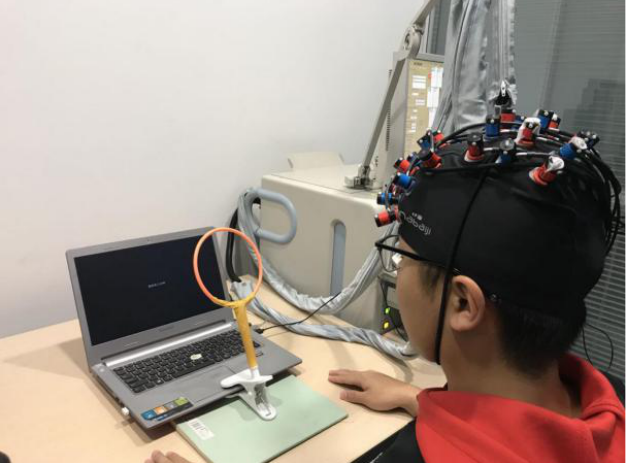
Figure 3. Experimental settings.